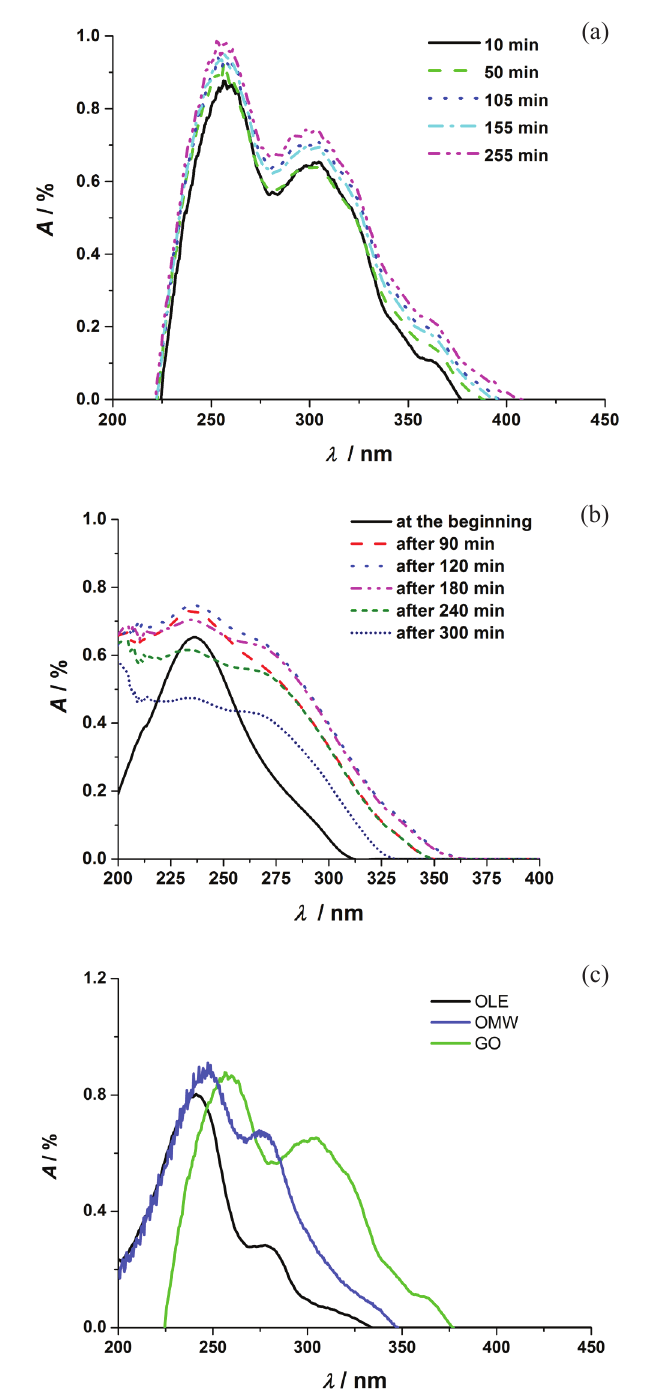
Fig. 1 – UV/Vis spectrum recorded a) during thermal treat- ment of GO, and b) during thermal treatment of GO in the pres- ence of OLE at pH=10. c) Comparison of UV/Vis spectrum re- corded for pure GO, OLE and